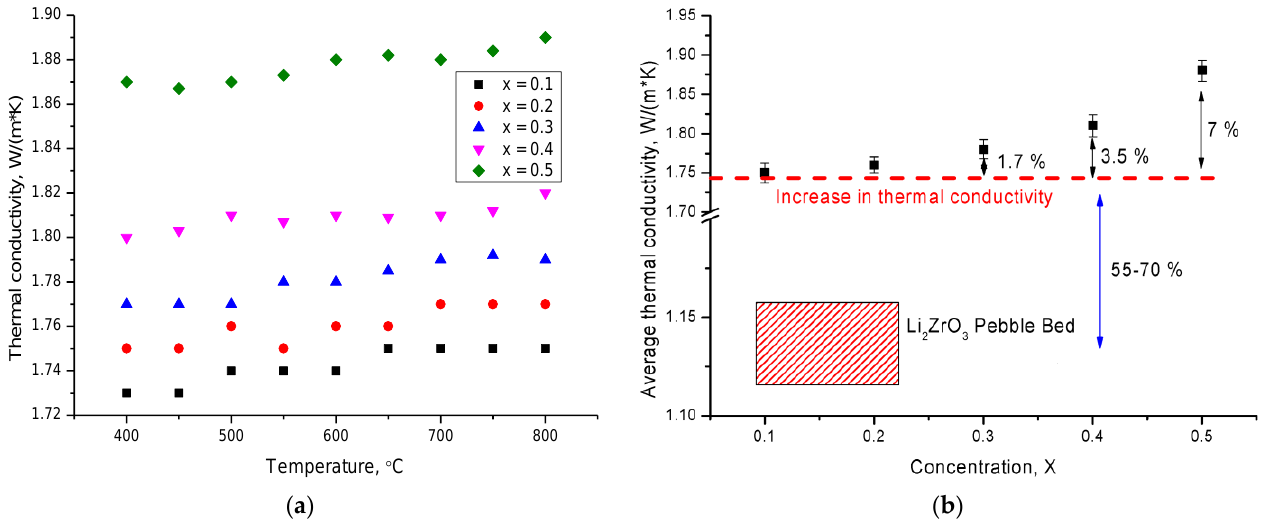
Figure 7. ( a ) Dependences of the change in the thermal conductivity coefficient on temperature; ( b ) results of the change in the average value of the thermal conductivity coefficient.